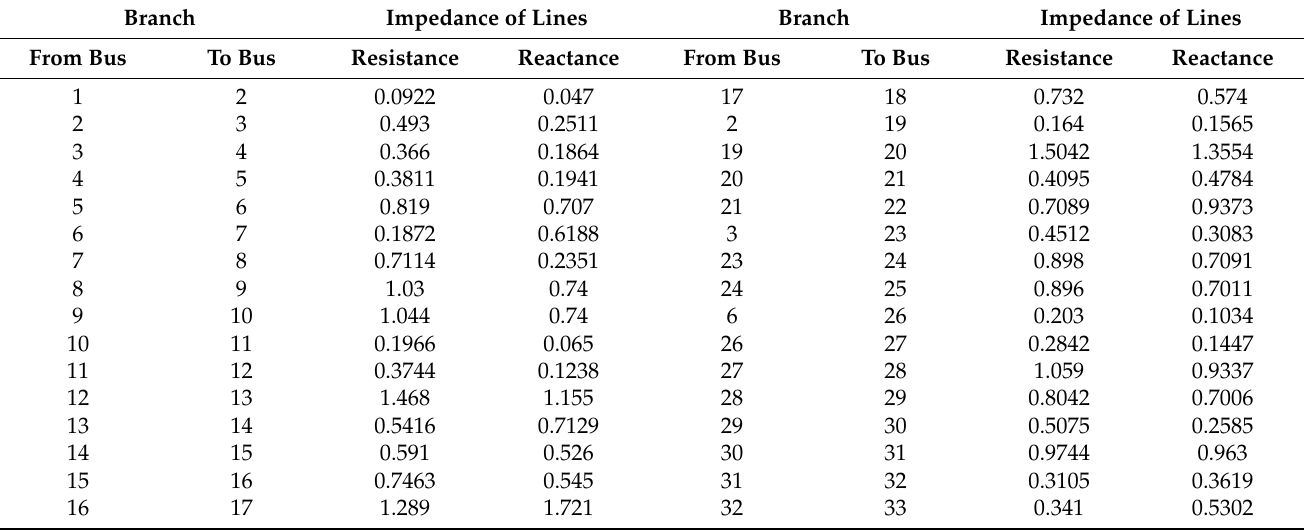
Table A1. The system information resistance and reactance at each branch of the IEEE 33-bus